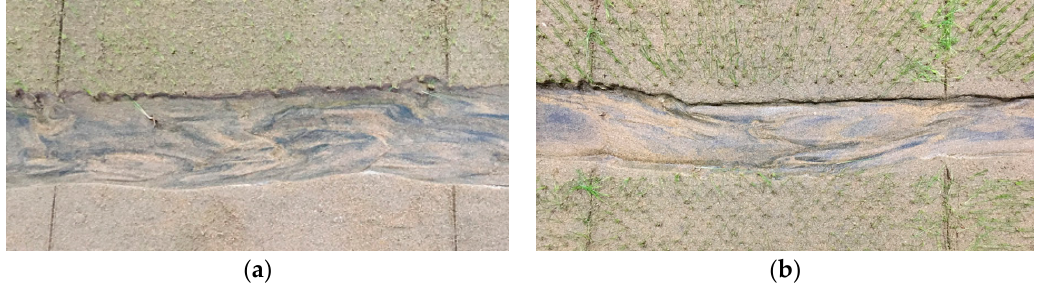
Figure 6. Channel morphology (( a ) Run 3 at t = 600 min); ( b ) the Mataura River near cattle flat (from Google Earth)).